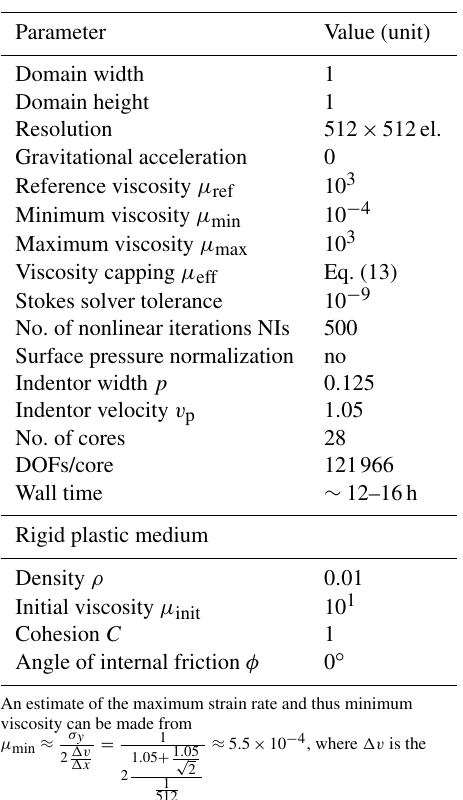
Table 3. The indentor benchmark model parameters.